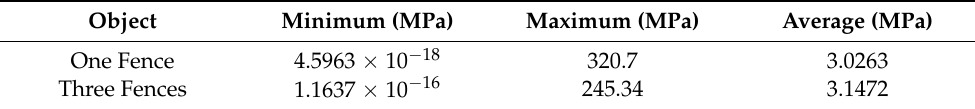
Table 5. Stress Values for an Angular Load of 100 N.